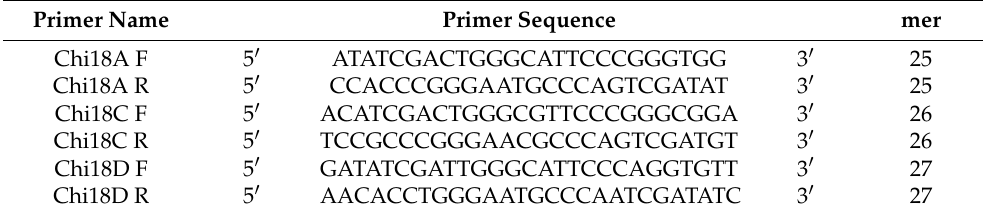
Table 3. Primers for site-directed mutagenesis.